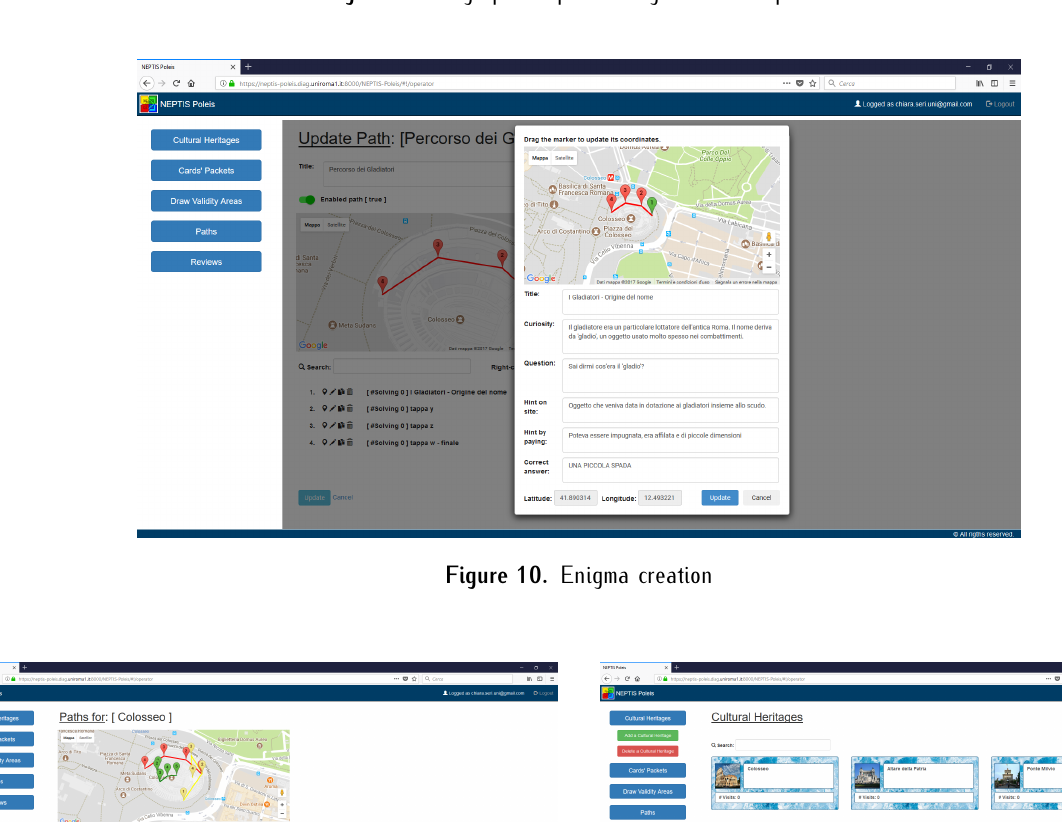
Figure 9. Geographical positioning of a cards’ packet